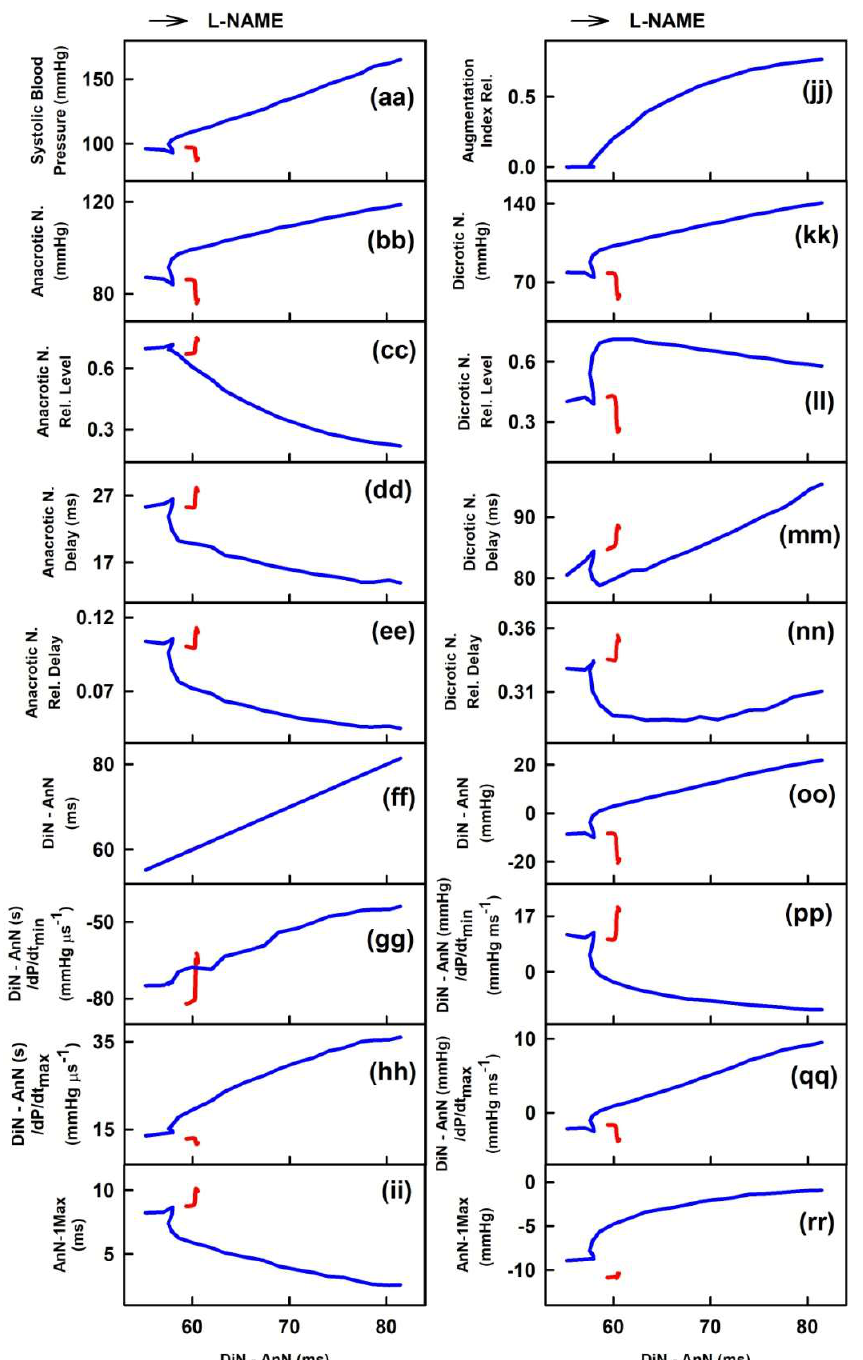
Figure 7. Two-dimensional cross-relationships of DiN-AnN time interval difference (in ms) to 34 rat HPs for conditions of increased/decreased NO bioavailability. The increase of NO bioavailability was caused by i.v. administration of 32 nmol kg −1 GSNO (red line; average from 10 experiments; data calculated from Figure 6 published in [22]). Red line was calculated from the time segment during which BP decreased after GSNO administration. The decrease of NO bioavailability was caused by i.v. administration of 25 mg kg −1 L-NAME (blue line; average from 6 experiments; data calculated from Figure 3 published in [23]). Blue line was calculated from the time segment during which BP increased after L-NAME administration. Arrow indicates the time direction after L-NAME administration.